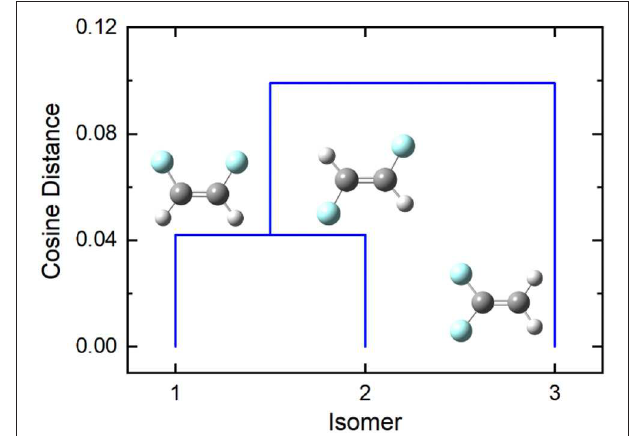
FIGURE 3 | The cosine distance dendrogram for difluoroethene. Molecular geometries were optimized at the PM6 level of theory as implemented in Gaussian 16 ( Frisch et al.,